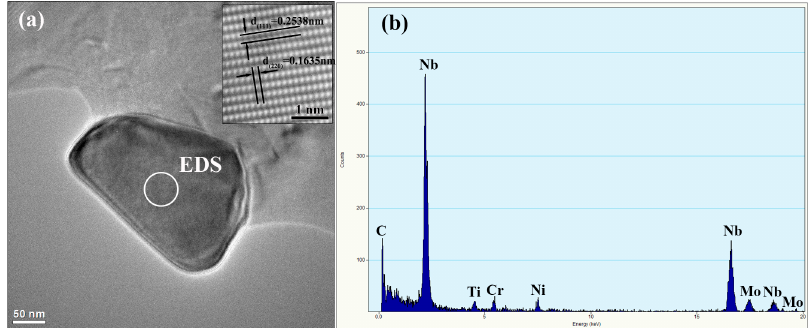
Figure 10. HRTEM images ( a ) of LARed samples in the RZ, and ( b ) the EDS results of a NbC precipitate.